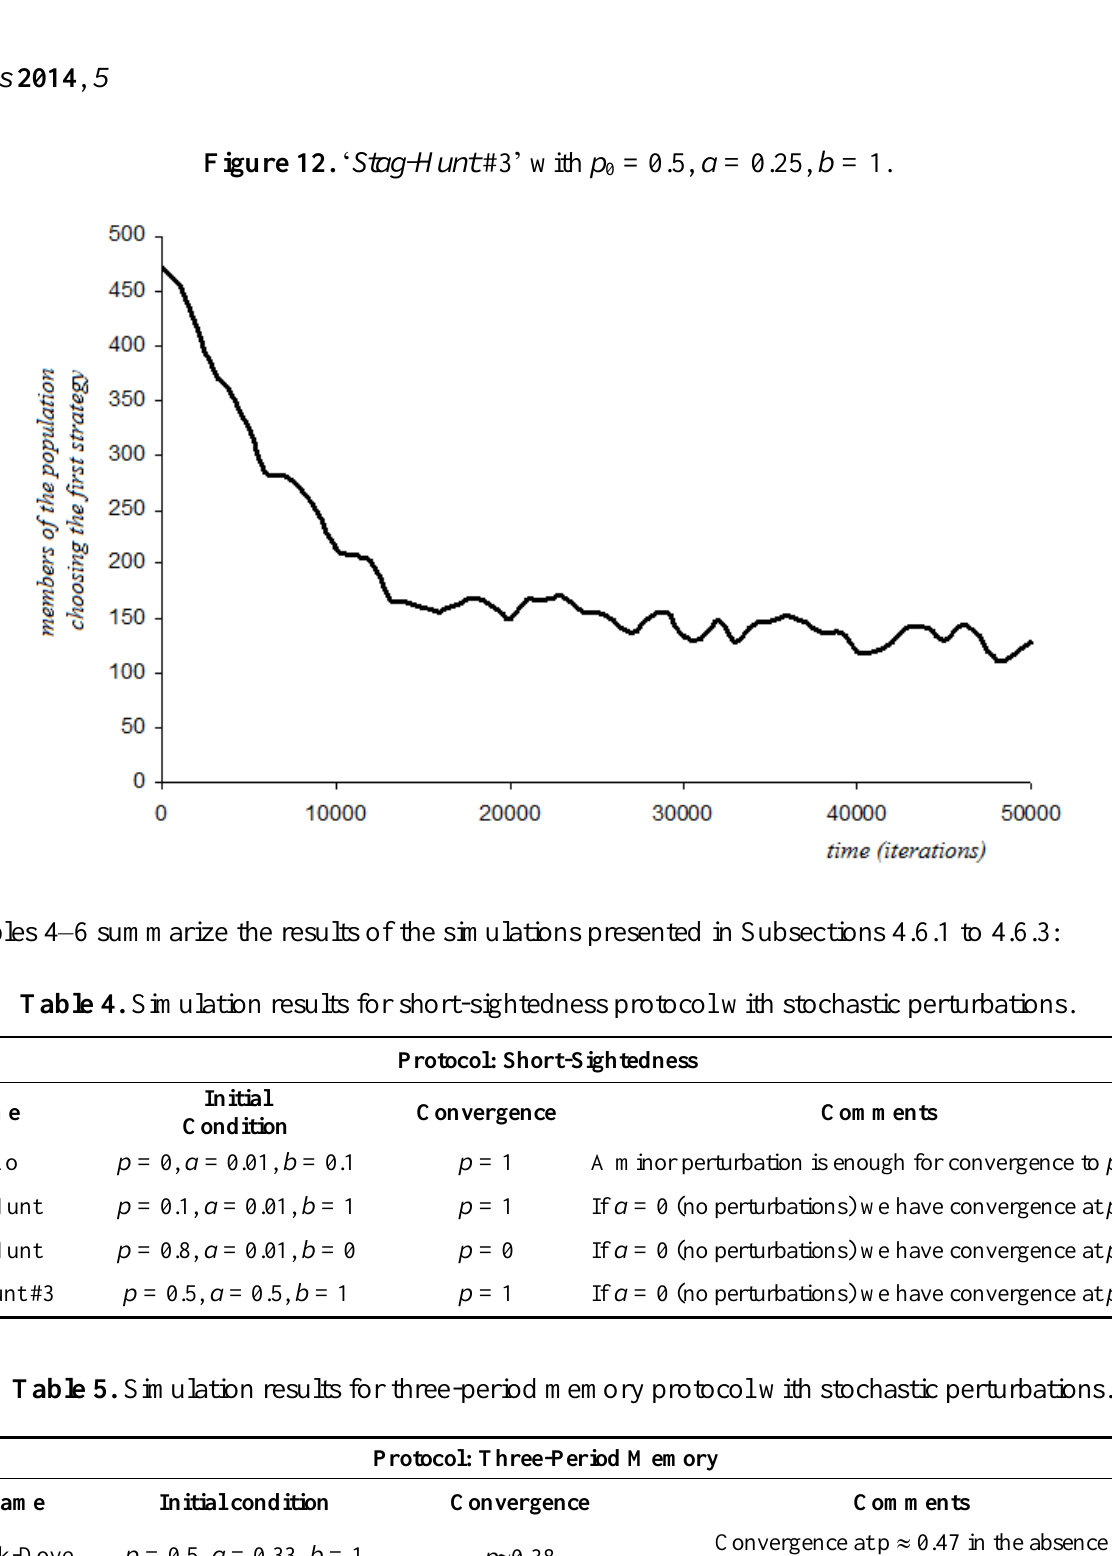
= 0.5, a = 0.25, b = 1. 0